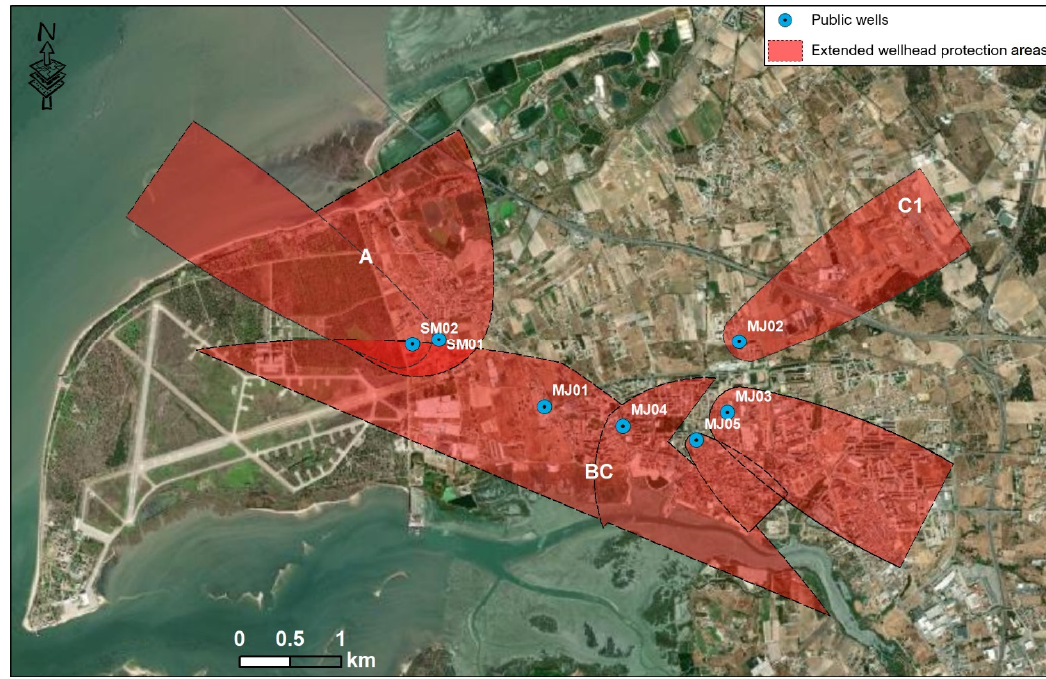
Figure 10. Extended wellhead protection zones delimited by the Wyssling method.